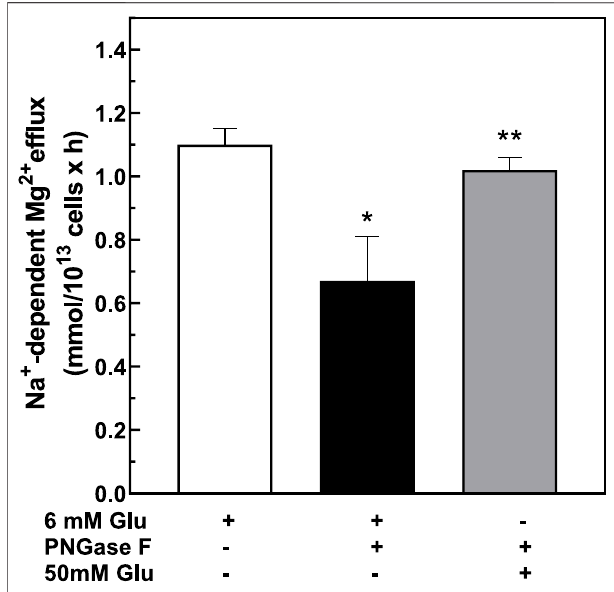
FIGURE 7 | Effect of PNGase-treatment on glucose-stimulated exchanger activity. Cells from T2D subjects were treated with 6 mM glucose or 50 mM glucose for 1.5 h after pre-treatment with 0.1 U/mL PNGase F and assayed for Na + /Mg 2+ exchanger activity as described in Methods. Values are expressed as means ± SEM of three experiments in triplicate determinations. * Non-parametric paired t test between 6 mM glucose (white bar) vs. PNGase-treated (black bar): * p < 0.002. Non-parametric paired t test between PNGase-treated vs. PNGase- and 50 mM glucose-treated (gray bar),** p <